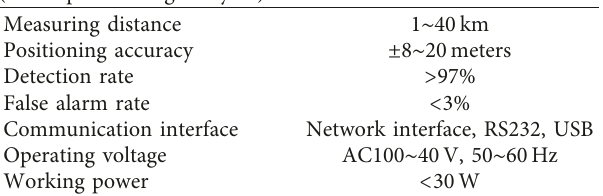
Figure 10: Distribution of impact strength on L00526 before and after repair. Table 3: Main technical indicators of the DOVS technology system (fiber optic sensing